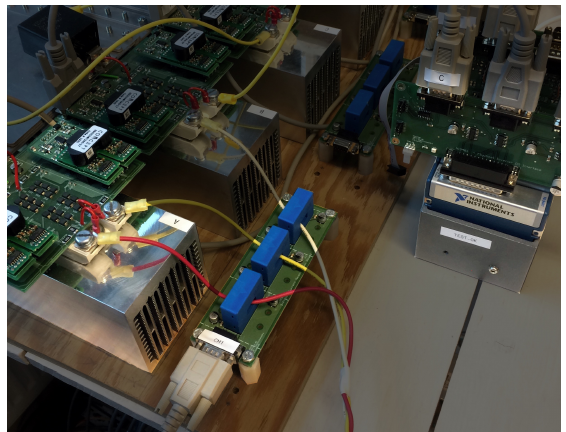
Figure 7. Photo of the single general purpose H-bridge used for driving the currents for system identification measurements, highlighted to the left. The current measurement board is seen in the middle, and the CompactRIO programmable automation controller used for sampling and storing of data is seen to the right.